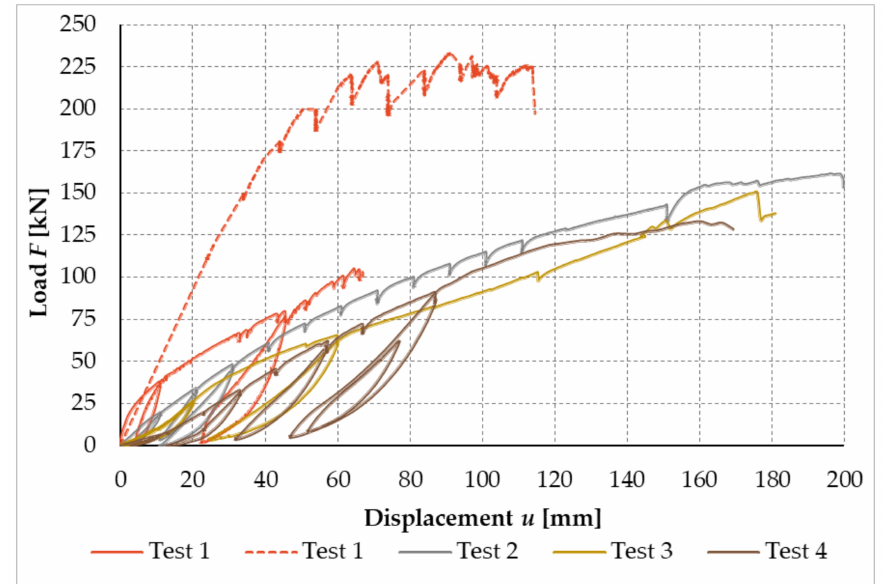
Figure 25. Load–displacement curves of experimental sample